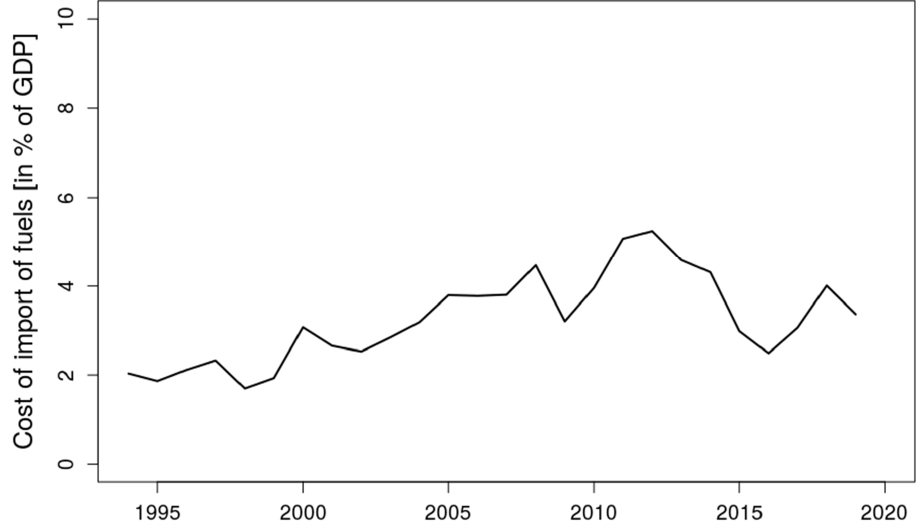
Figure 4. Cost of energy imports compared to GDP (1994–2020). Source of data: EUROSTAT [38]. Indeed, the energy market in Poland (and other Visegrad countries) is in transition from a state-dominated, centralized one towards a decentralized energy market [41]. Fig- ure 5 represents this trend by showing the growing number of electricity generating com- panies (representing at least 95% of the national net electricity generation). As a result, opportunities for new energy technologies and market actors continue to rise.